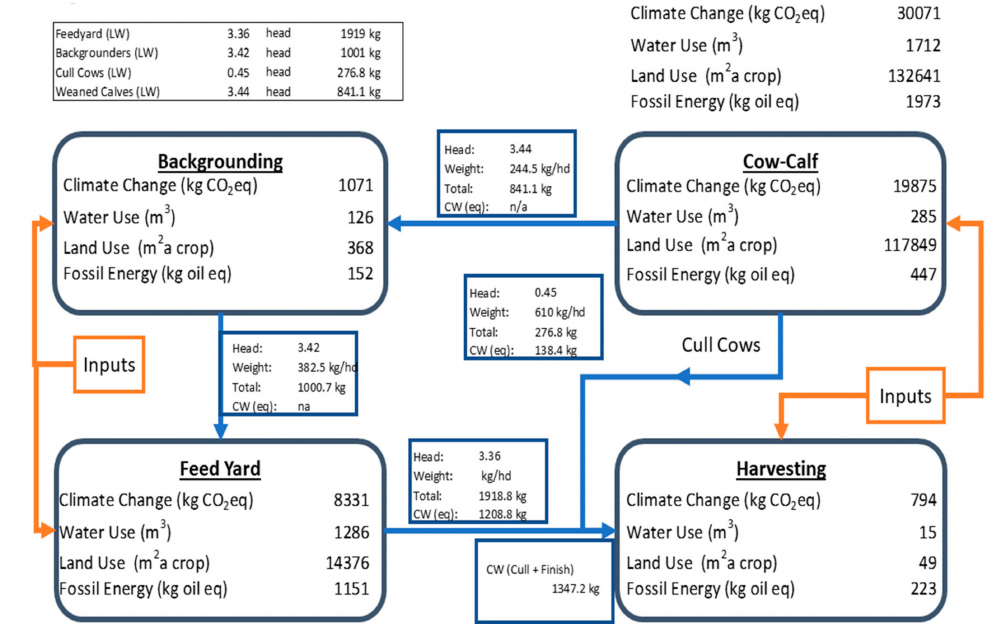
Figure 3. Base case for 1000 kg of retail cuts. Truncated BG; Full FY; Conventional Corn.